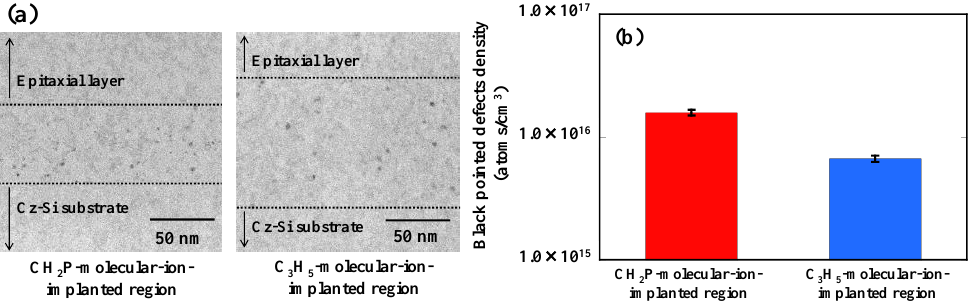
Figure 7. ( a ) Cross-sectional TEM images of CH 2 P- and C 3 H 5 -molecular-ion-implanted regions with epitaxial silicon wafers. ( b ) Density of black pointed defects distributed in CH 2 P- and C 3 H 5 -molecular-ion-implanted regions.